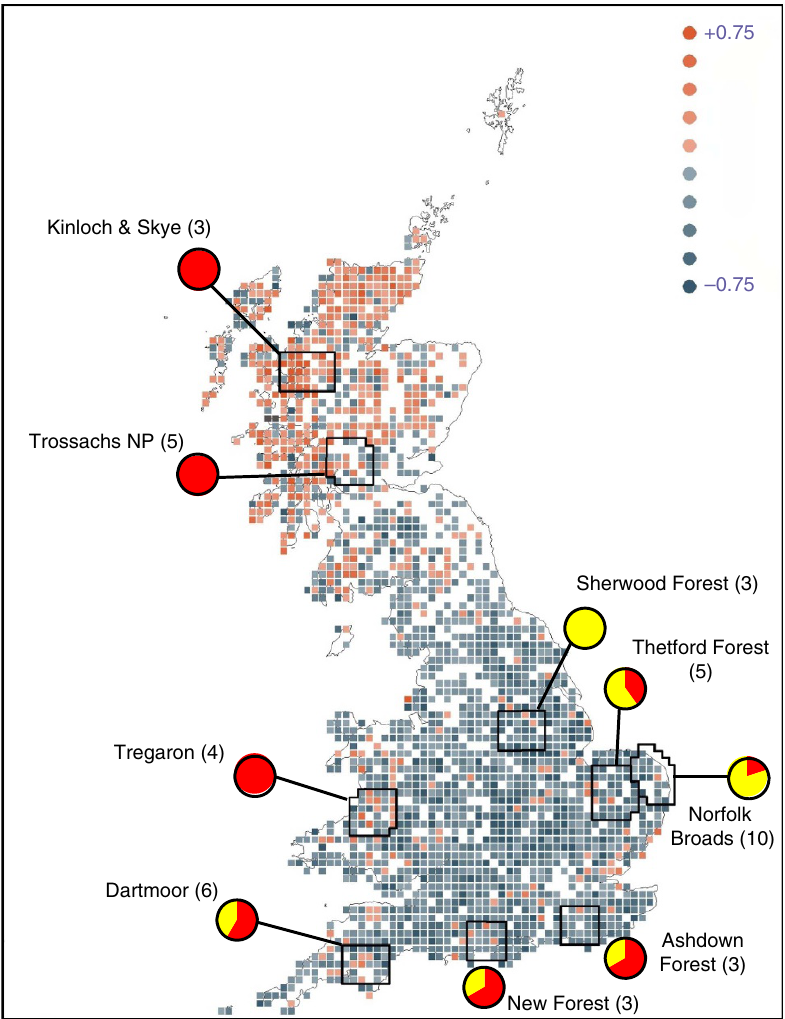
Figure 1 | Cuckoo migration route use and breeding population change for each tagging location. Population change is shown at 10km 2 resolution. For each tagging location, pie charts show the proportion of tagged birds that migrated East (red) and West (yellow) (sample size of birds is given in parentheses after each tagging location name) and black polygons outline the 10km 2 area that contributed to the population change index (see Methods and Supplementary Tables 1 and 2). Colour of 10km 2 indicates the proportional population change between the BTO Atlases in 1988–91 and 2007–11 according to the scheme shown in the figure, with dark pink indicating the largest increase, dark grey the largest decrease and white indicating no change 15